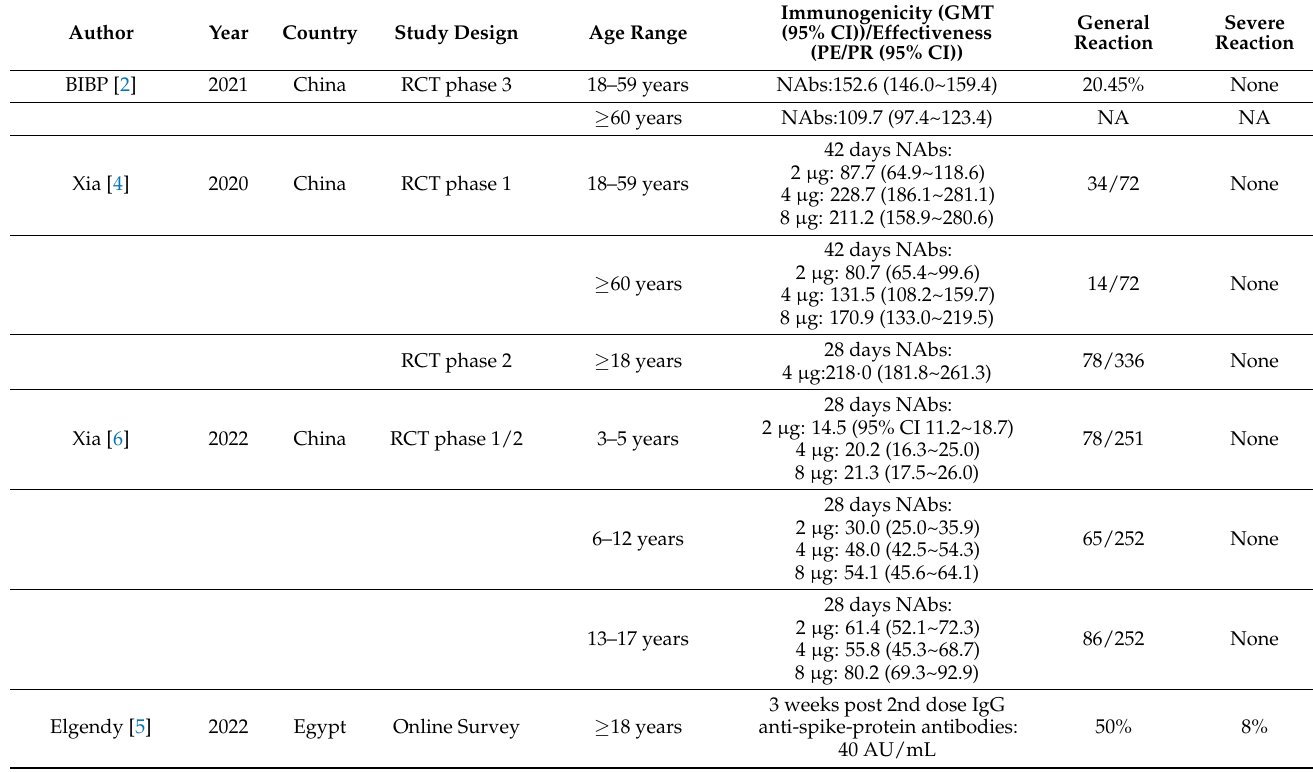
Table 1. A summary of the safety, immunogenicity, and effectiveness of